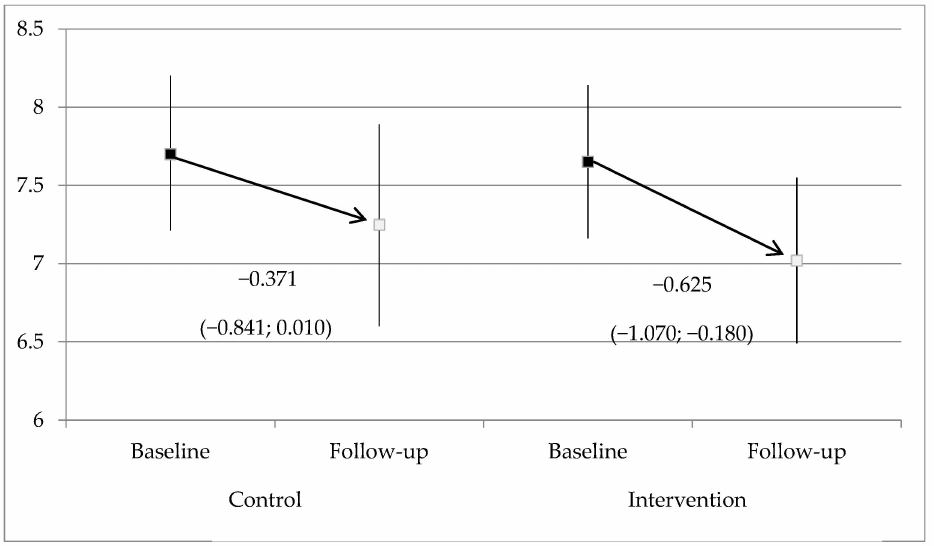
Figure 1. Evolution of REGICOR cardiovascular risk during follow-up by study group (mean and 95%